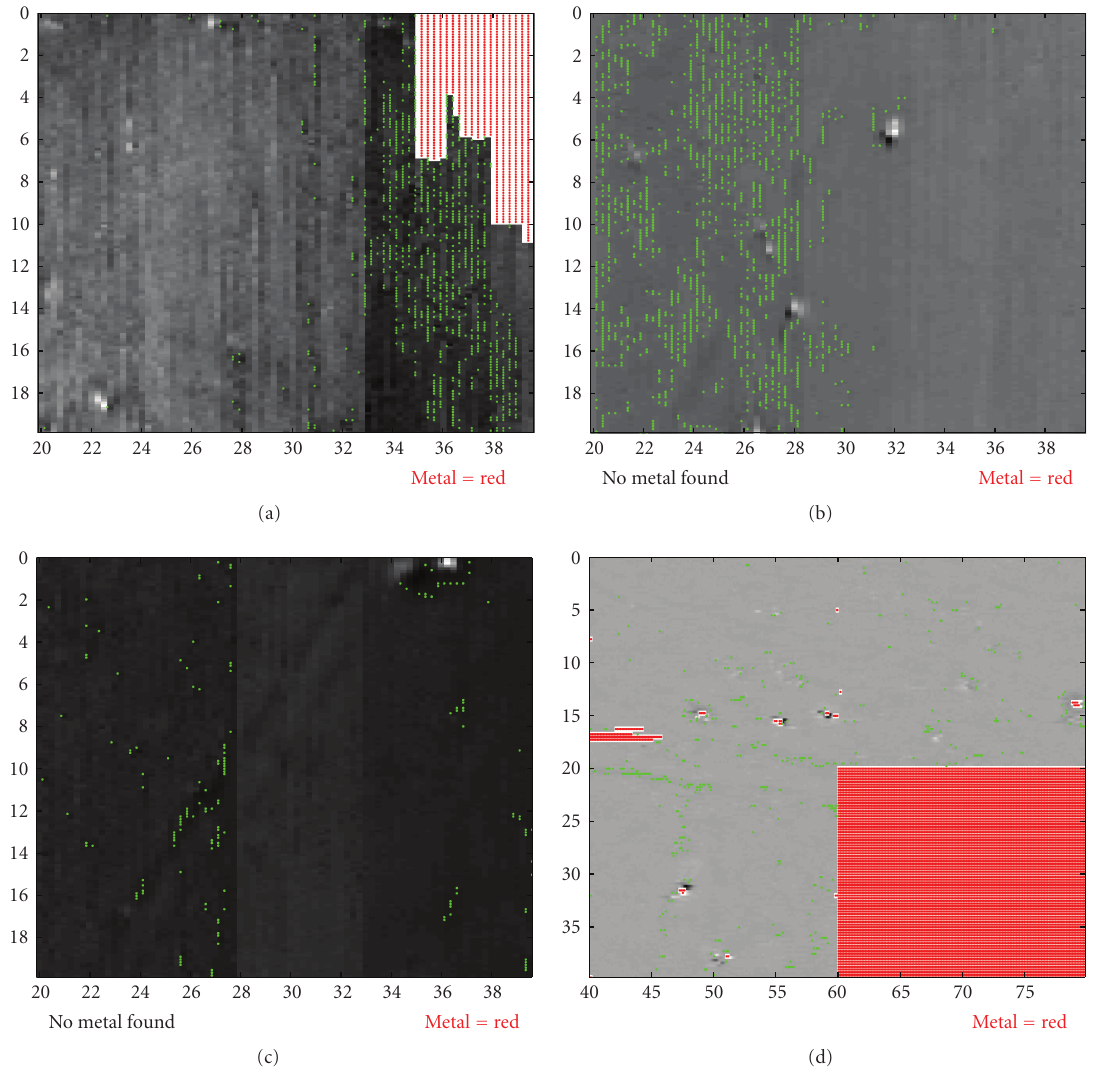
Figure 10: Data sets resulting from fuzzy cuto ff values using the MATLAB function gbellmf( x , [0 . 75,3, − 4]). As in Figure 8, subplots represent di ff erent scan areas enumerated in Figure 1. For a more detailed description of gbellmf , see the appendix.